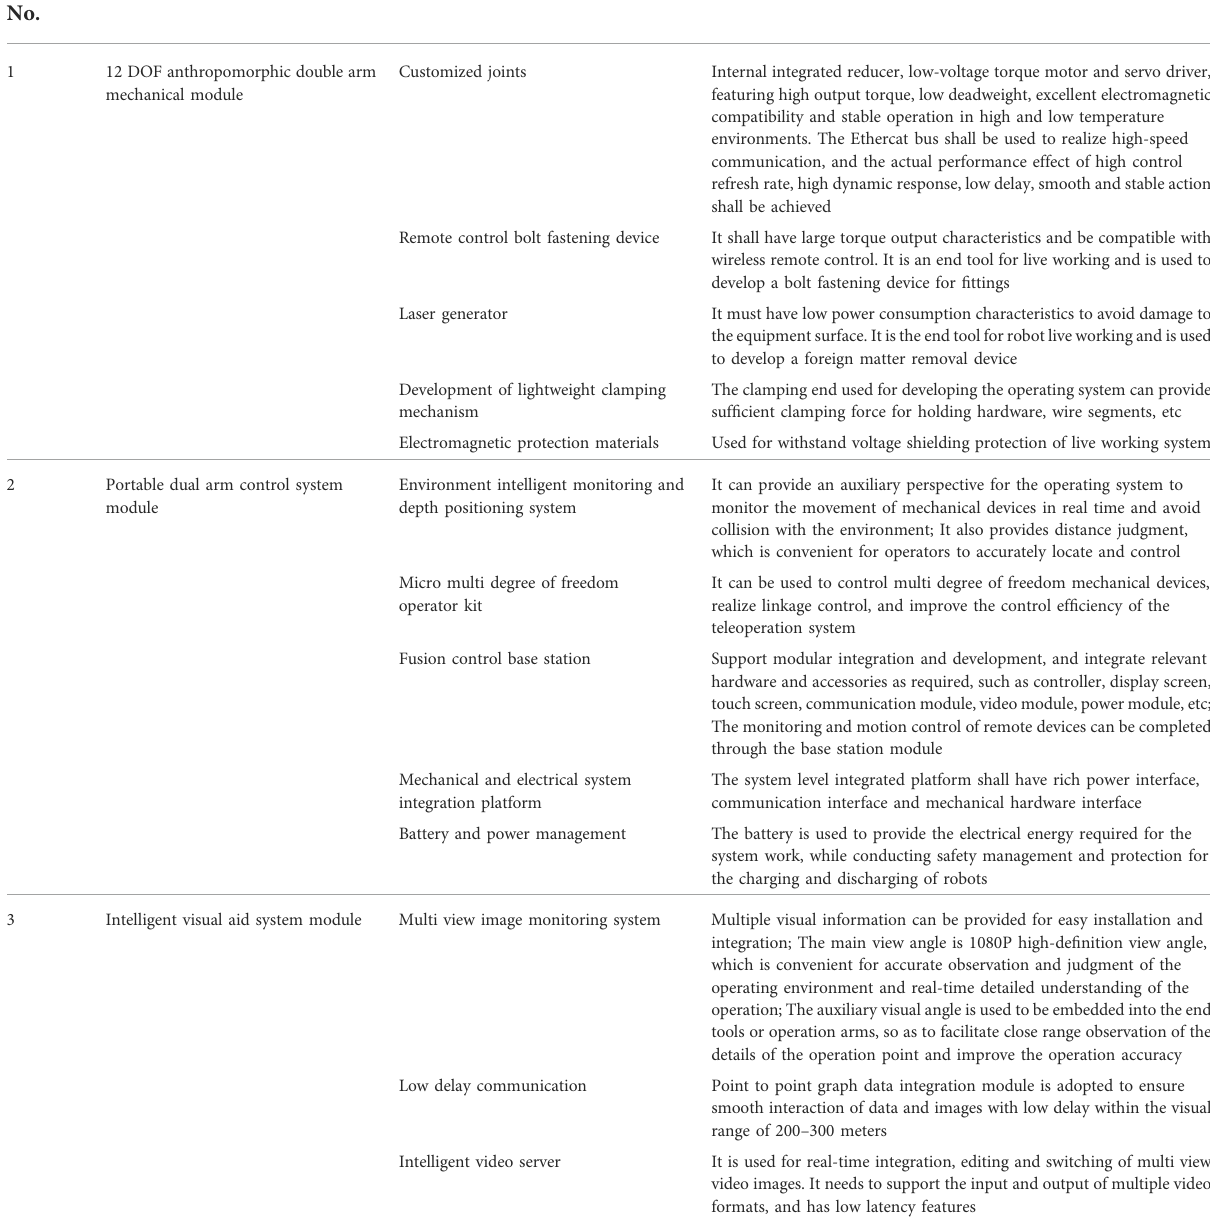
TABLE 1 Functional requirements of intelligent equipment for 110 – 220 kV substations. Serial